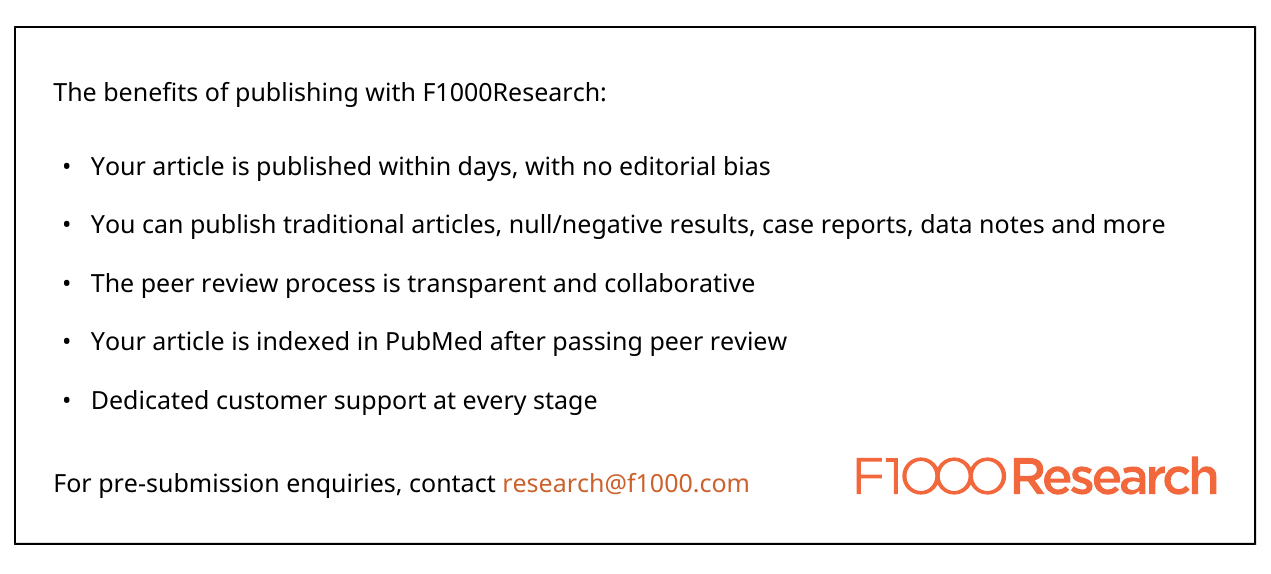
Fig.1 a . The accuracy obtained with these models is compared to the watershed approach and to a Stardist model trained with the 2018 Data Science Bowl. As Mask R-CNN demonstrates the most accurate results, the segmented nuclei obtained with this approach are then manually corrected to initialize a training dataset. To clarify the misleading text “Only one image was used to train […]” , we changed the Training dataset section in Methods and added that publicly available datasets were used in addition to the manually annotated image of human precancerous polyp biopsy. We added a sentence about the time taken to train a Mask R-CNN model on the CC/MIE datasets at the end of the first section to better compare the 30 hours of manual annotation from scratch vs. the 15-20 hours when using this